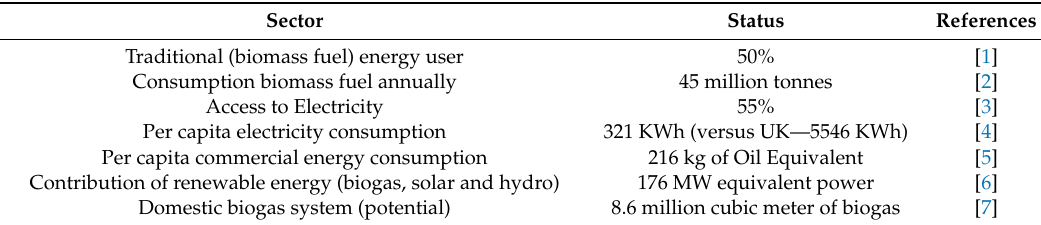
Table 1. The state of energy reliance in